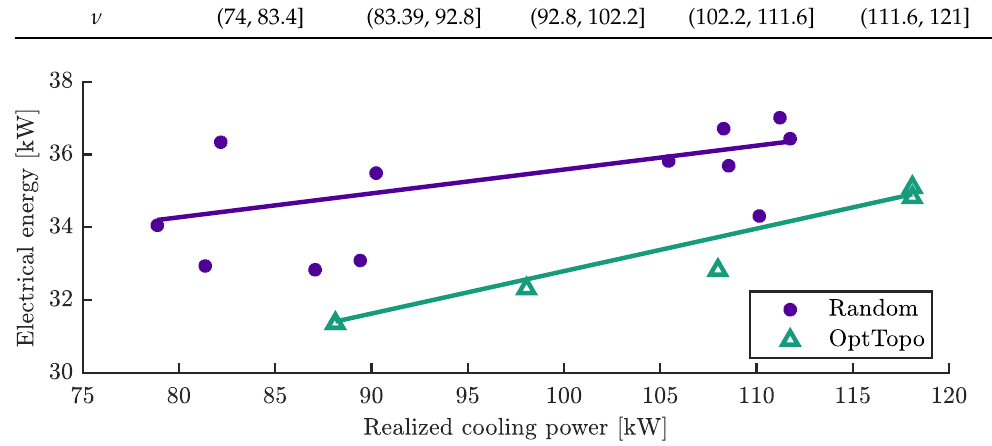
Figure 3. Operation points resulting from solutions from OptTopo together with operation points from randomly chosen configurations. The former ones prove to realize a lower demand for electrical energy in this sample. A regression illustrates this trend.